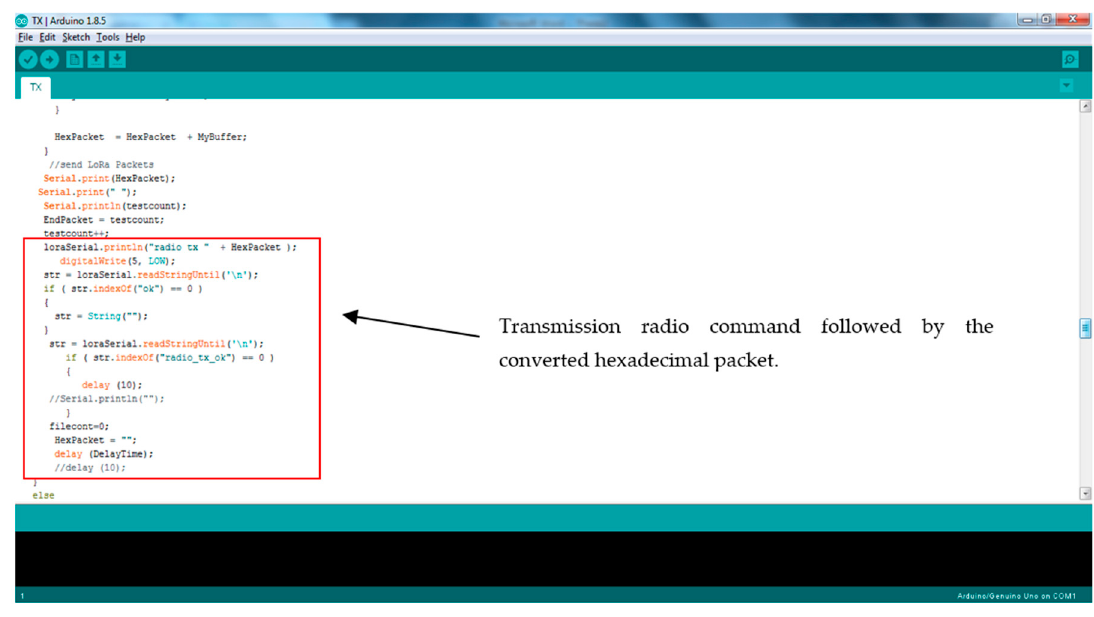
Figure A3. LoRa command for transmission of the hexadecimal packets.